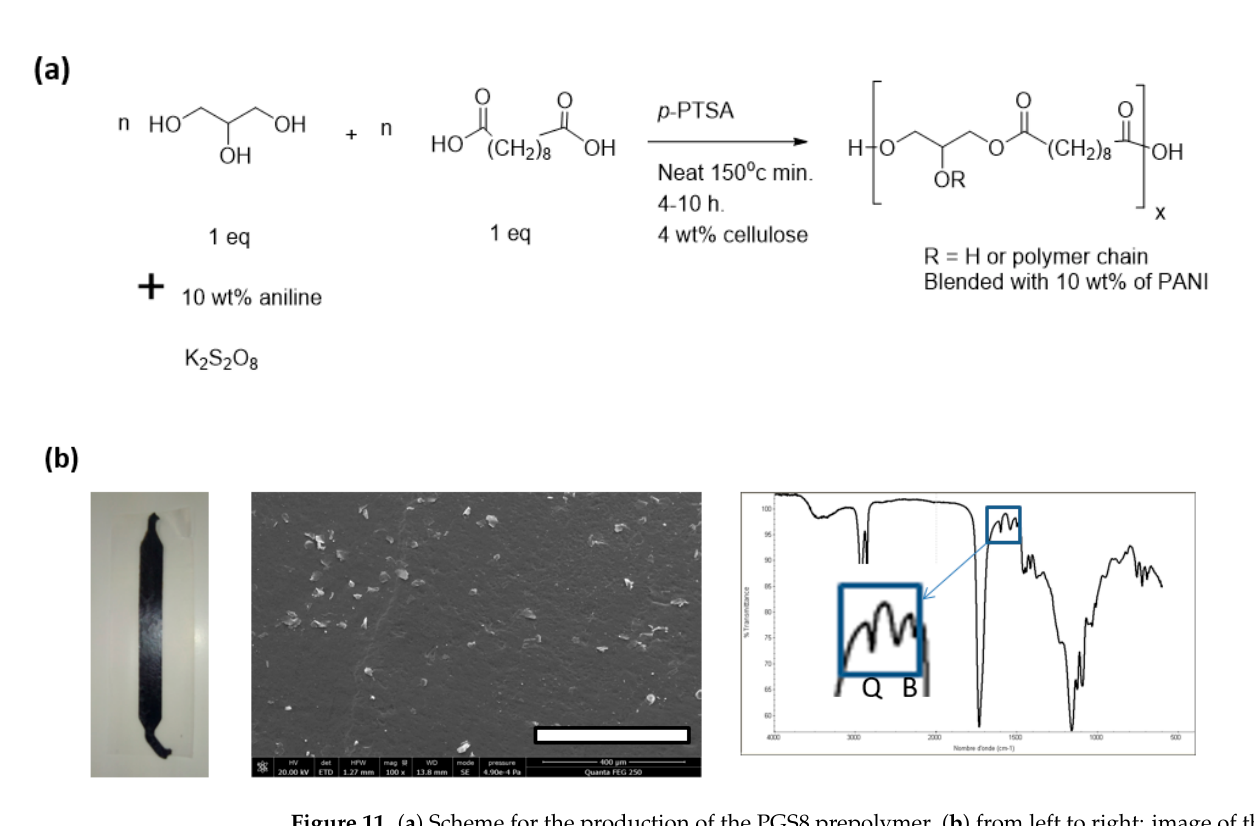
Figure 11. ( a ) Scheme for the production of the PGS8 prepolymer. ( b ) from left to right: image of the bioplastic composite sheet of PGS8; photograph of the FE-SEM observation of the PGS8 surface (scale bar = 400 µm); and its corresponding FTIR spectrum. R—H or polymer chain; Q—Quinoid units; B—Benzoid units.